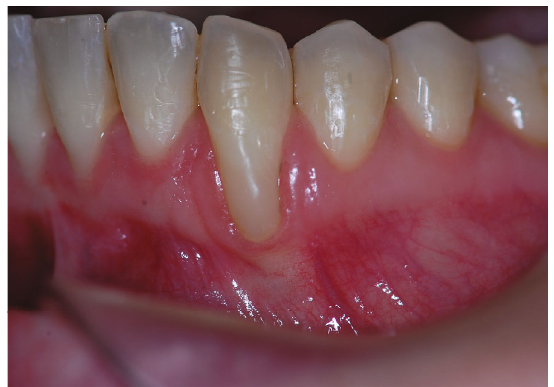
Figure 2: Preoperative close view showing the root defect covered with composite and an absence of keratinized tissue.